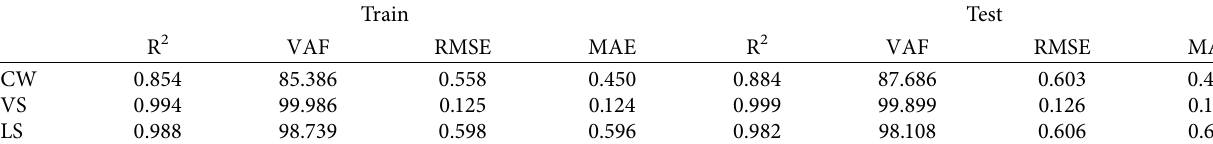
Table 4: Performance indicator values for building MLR models for outputs.